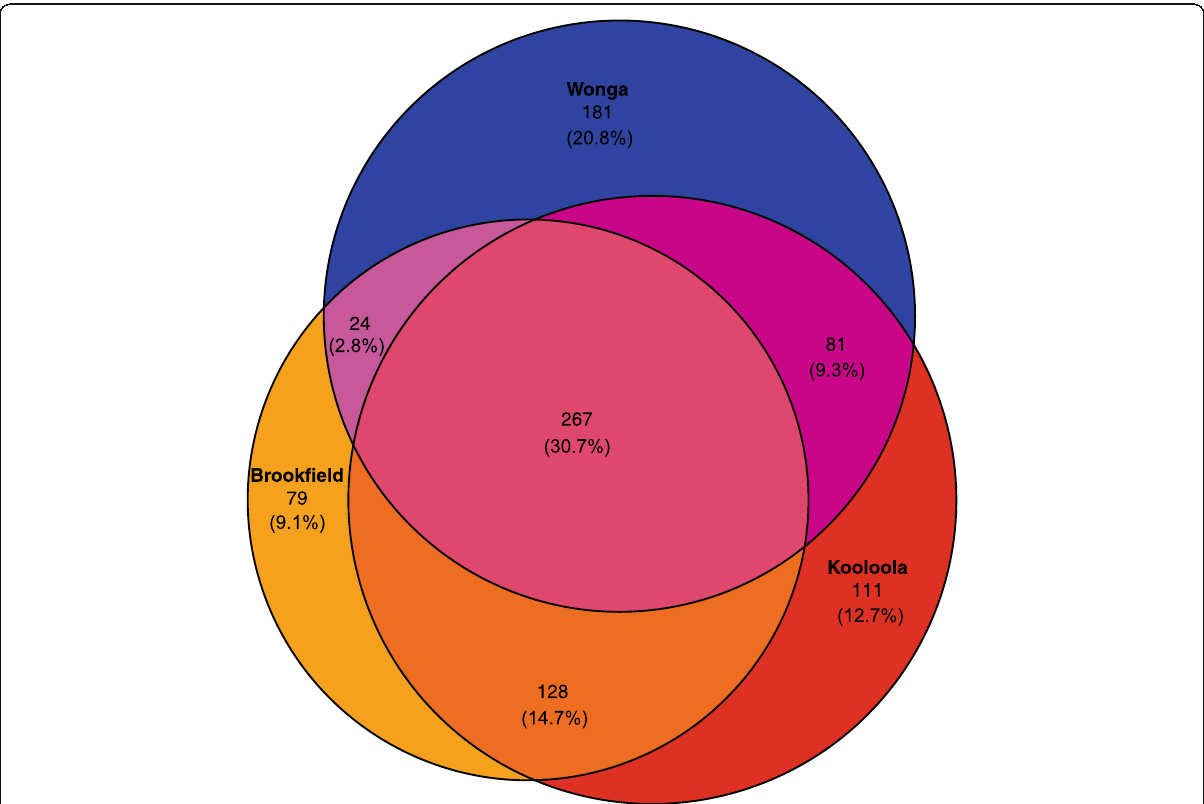
Fig. 5 Venn diagram of ASVs shared and unique between different SHNW populations, with the percentage of total ASVs listed for each region. Wonga (intact habitat), Kooloola and Brookfield (degraded